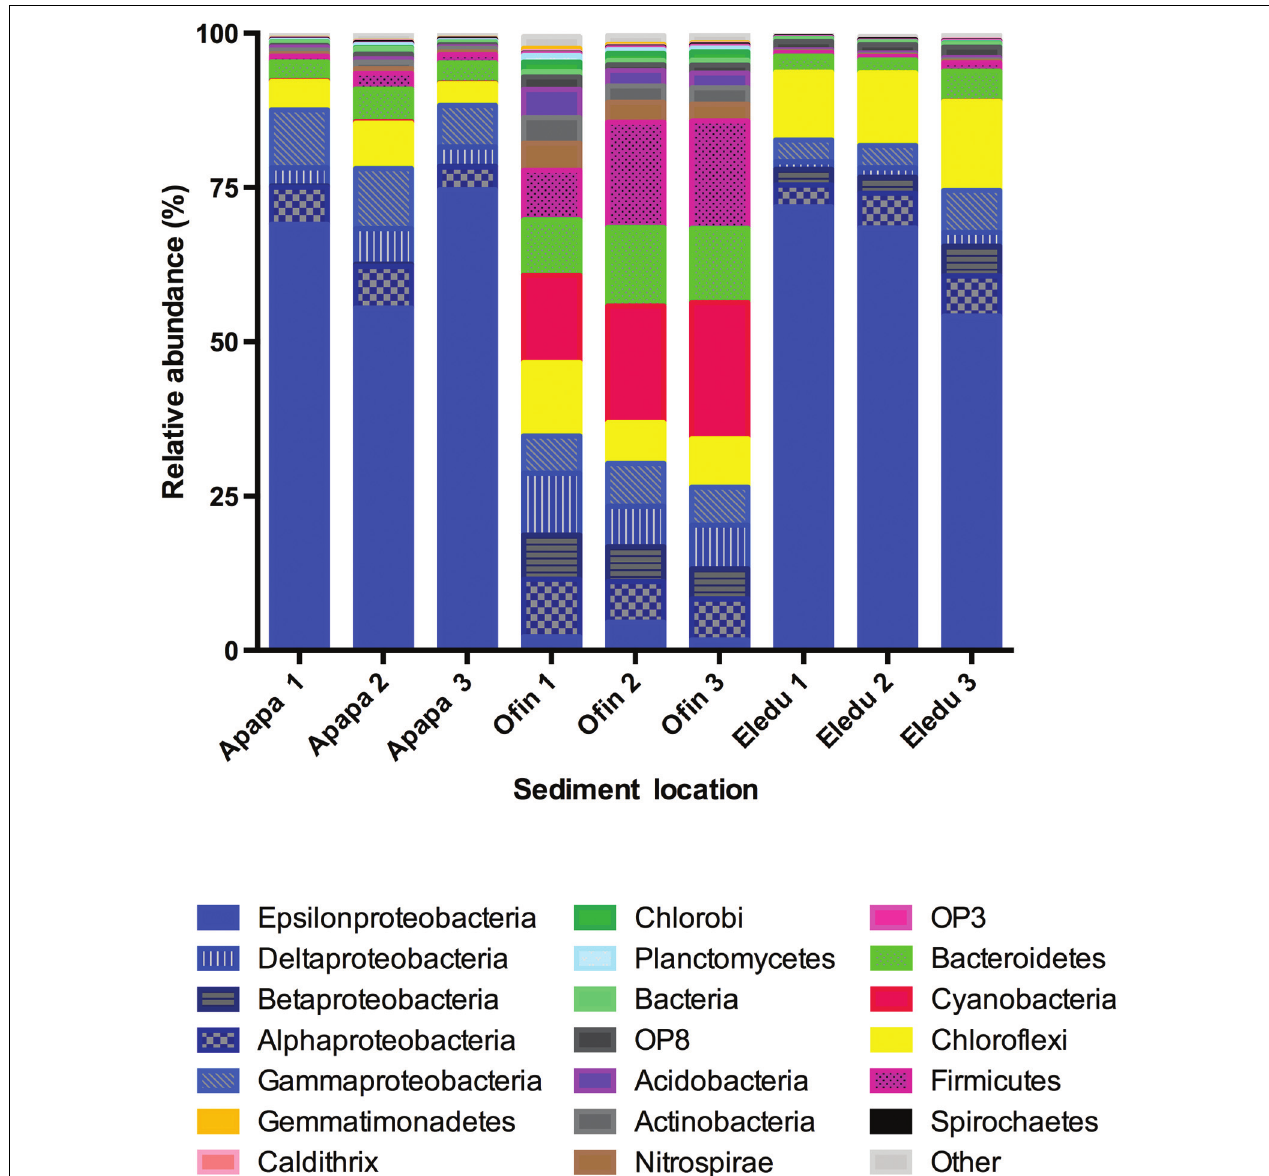
FIGURE 5 | Relative abundance of major bacterial phyla in Lagos Lagoon sediments. The phlyum Proteobacteria is subdivided by class (all color-coded